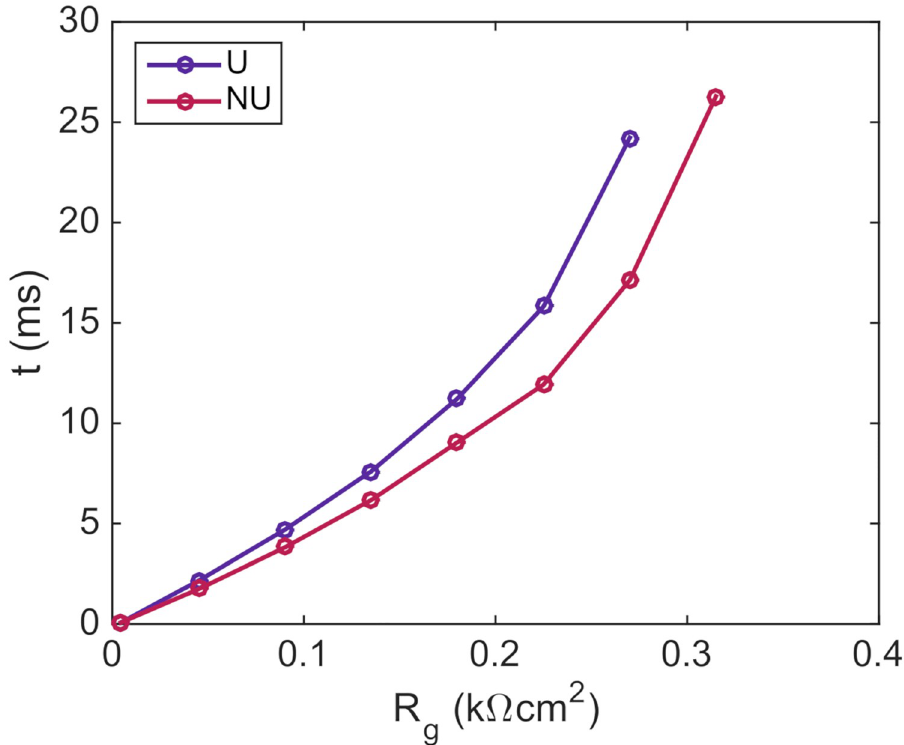
Fig 10. The time delay across gap junctions of reduced coupling is longer for a uniform (U) distribution than for a non-uniform (NU) distribution of sodium channels. The simulation includes a row of ten cells and the gap junction resistance between the fifth and sixth cells is increased by a factor of up to 70 from the default value of R k O cm 2 . The default value of R g is used for the remaining gap junctions. The remaining parameters used in the simulations are given in Table 1, except that the time step is set to Δ t = 0.01 ms. The timings reported in the plot are the time between the end of the fifth cell and the start of the sixth cell reach a membrane potential of v = 0 mV. In the NU case, all the sodium channels are located on the horizontal part of the cell ends (see Fig